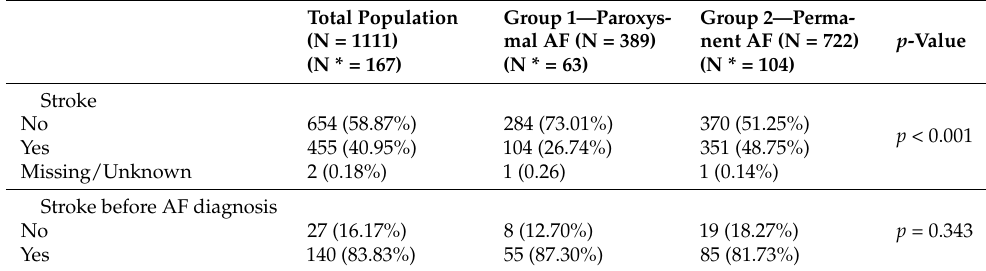
Table 11. Presence of stroke in the two study groups and its presence before the diagnosis of